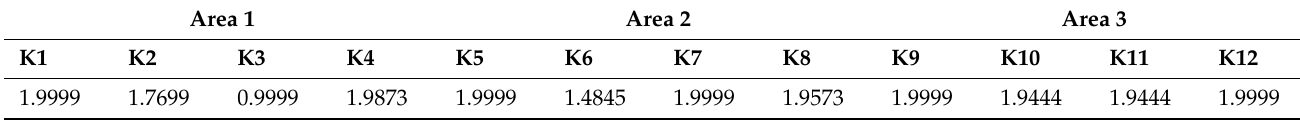
Table 2. Optimum gains parameter values of FPID controller with HVDC link.